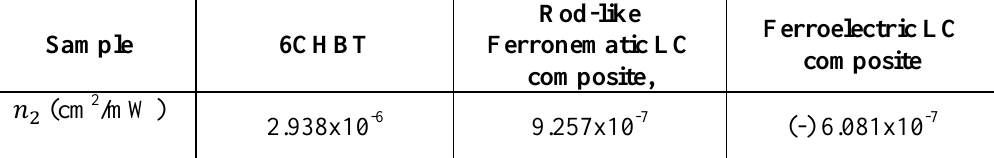
Fig.5: The nonlinear refractive index, (a) 6CHBT, (b) Rod-like Ferronematic LC composite, and (c) Ferroelectric LC composite. Table 2: The nonlinear refractive index of the samples under